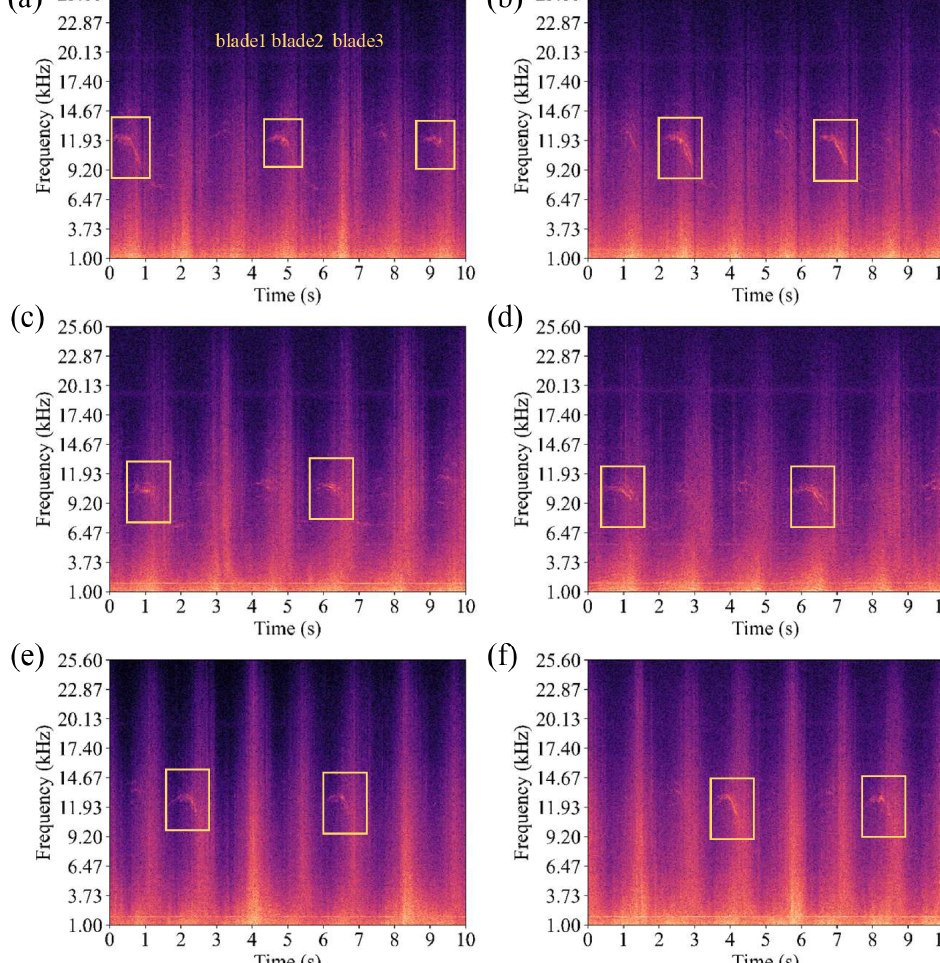
Figure 8. Time–frequency map at different locations: ( a ) A; ( b ) B; ( c ) C; ( d ) D; ( e ) E; ( f )